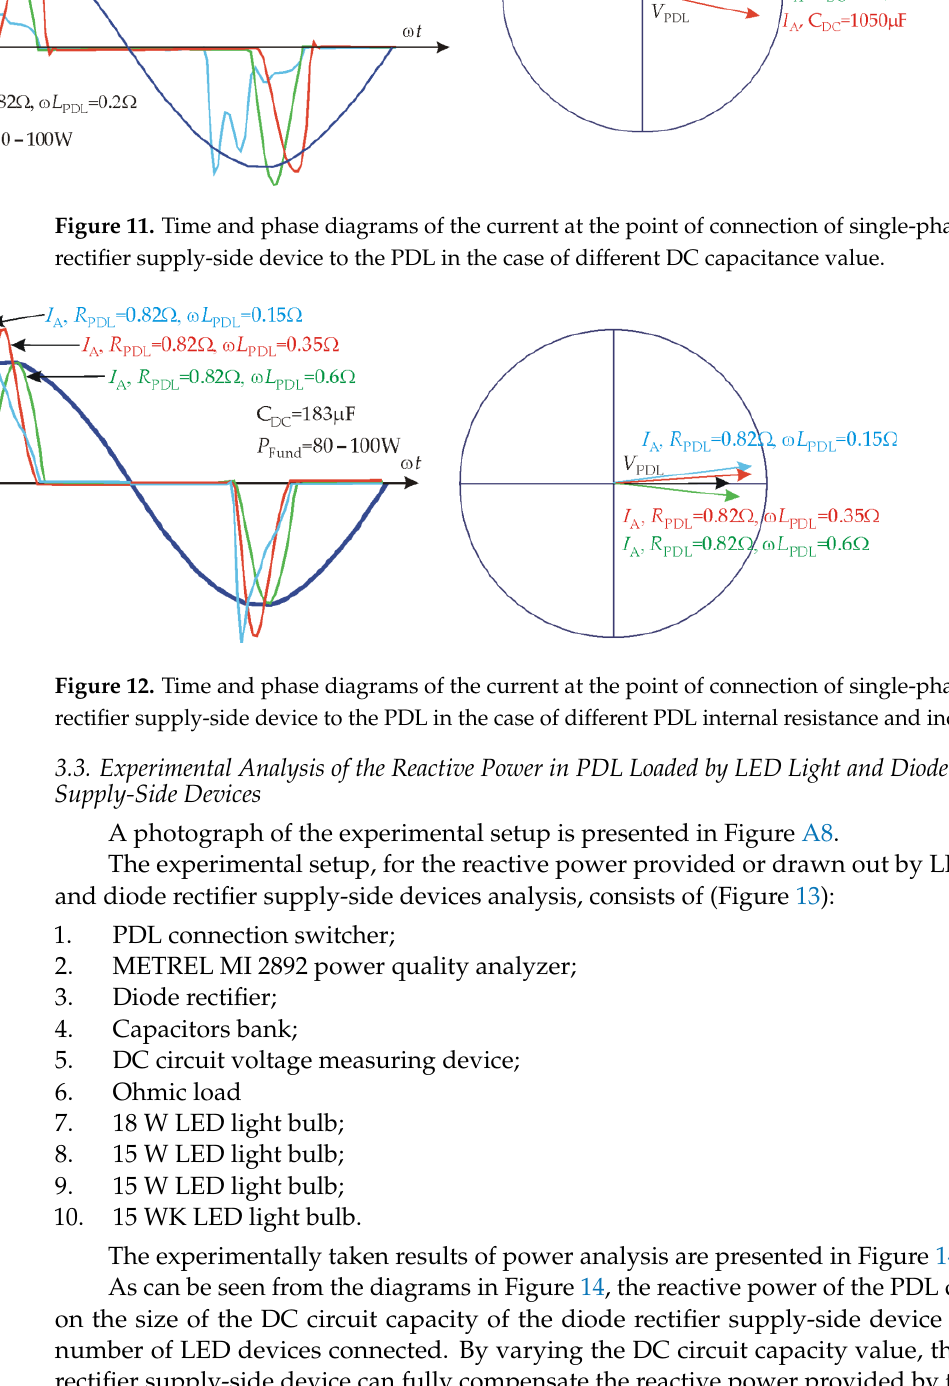
Figure 13. Circuit diagram of experimental setup for the reactive power provided or drawn out by LED light and diode rectifier supply-side devices analysis. The experimentally taken results of power analysis are presented in Figure 14.